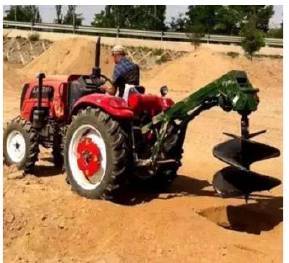
Figure 15. Drill pole tree-planting machine.